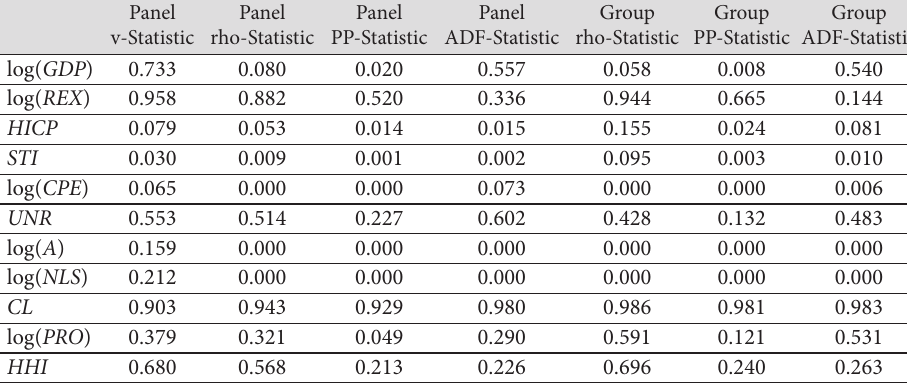
Table 12. Panel co-integration tests (long term variables of NII equation) Panel Panel Panel Panel Group Group Group v-Statistic rho-Statistic PP-Statistic ADF-Statistic rho-Statistic PP-Statistic ADF-Statistic –0.967 –3.457 –10.667 –10.155 –1.306 (0.833)